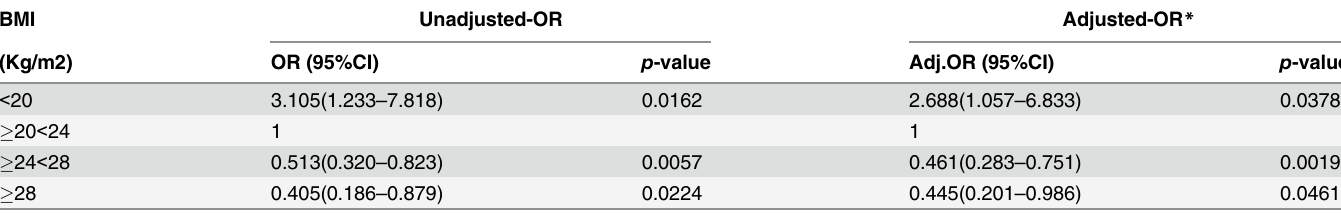
Table 4. Comparison of the detection rate of osteopenia or osteoporosis in different BMI group.